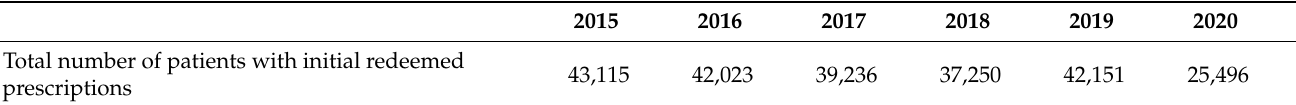
Table 3. Incidence of T2DM patients ( n ) with initial antihyperglycaemic agents between 2015 and 2020. (Top 10 treatment patterns with the highest